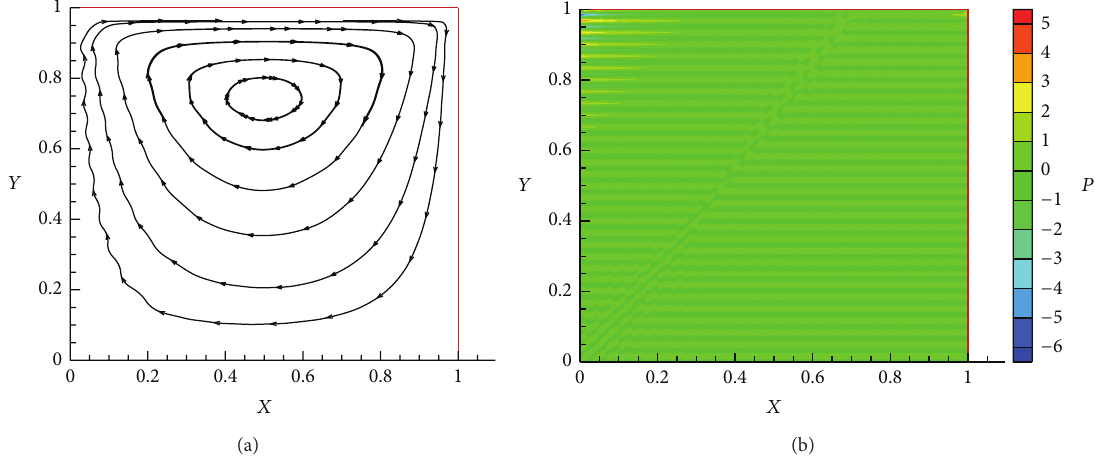
Figure 1: Velocity streamlines (a) and pressure level lines (b) for the penalty method with 𝜀 = 1.0𝑒 − 6 , 𝛼 = 100 , and 𝑟 = 4 , respectively.